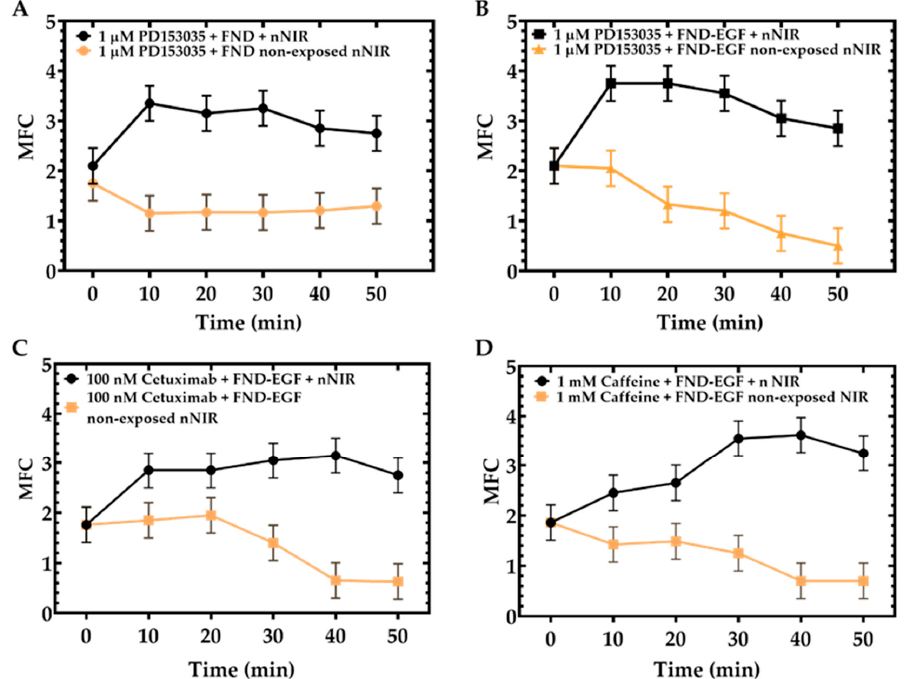
Figure 6. Drug treatment with A549 cells ( n = 50) and exposed to 224.02 J/cm 2 nNIR. ( A ) illustrates cells treated with 1 µ M PD153035 and 100 nM FND was exposed to 224.02 J/cm 2 nNIR for 10 s there was an increase in MFC compared to non-nuclear exposed cell (MFC: 2.8 ± 0.3 nNIR, vs. 1.3 ± 0.3 non-NIR). ( B ) illustrates cells treated with 1 µ M PD153035 and conjugated 100 nM FND-EGF then exposed to 224.02 J/cm 2 nNIR for 10 s and imaged at different time points, analysis showed an increase in MFC (MFC: 2.9 ± 0.3 nNIR, vs. 0.5 ± 0.3 non-NIR) of cell nucleus exposed to NIR compared to non-nuclear exposed cells. Cetuximab treated A549 cells and conjugated 100 nM FND-EGF were exposed to 224.02 J/cm 2 nNIR, and analysis showed an increase in MFC compared to the non-nuclear exposed cells (MFC: 2.8 ± 0.3 nNIR vs. 0.6 ± 0.3 non-NIR), as shown in ( C ). A549 cells treated with conjugated 100 nM FND-EGF and 1 mM caffeine were exposed to 224.02 J/cm 2 nNIR at different time points. Analysis showed an increase in MFC of nuclear exposed cells compared to non-NIR cells (MFC: 3.3 ± 0.3 nNIR, vs. 0.7 ± 0.3 non-NIR), as shown in ( D ). Statistical analysis was performed by one-way